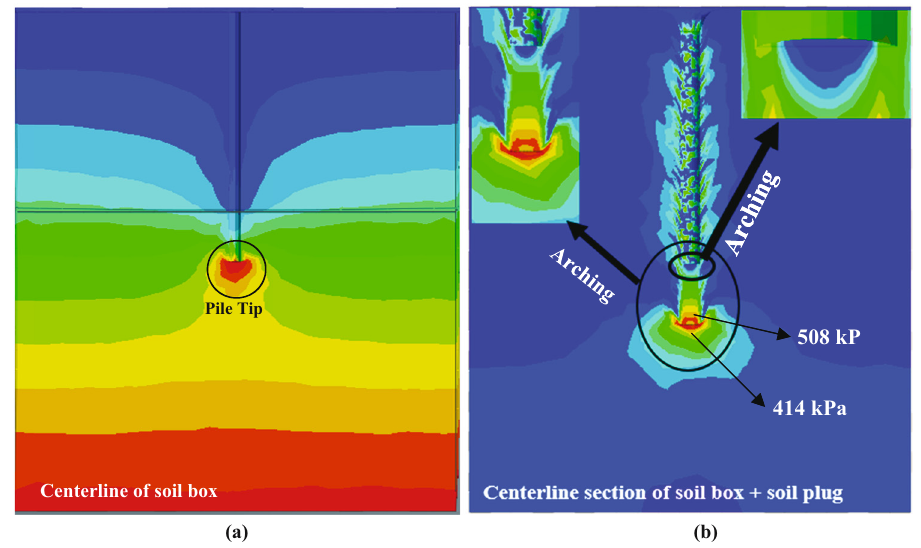
Figure 5: Contour lines of the shear stress in the y – z direction after applying fully coupled static and dynamic loads: ( a ) closed - ended pipe pile and ( b ) open - ended pipe pile.